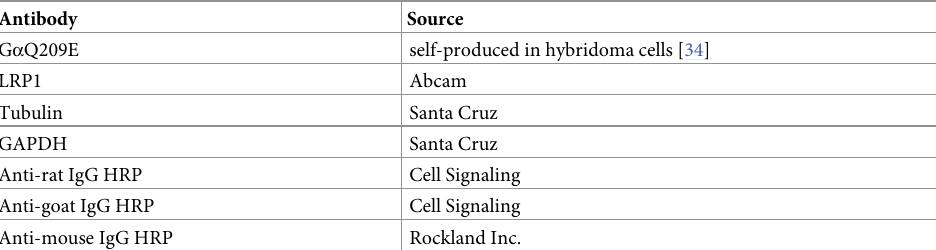
Table 2. Antibodies used in this